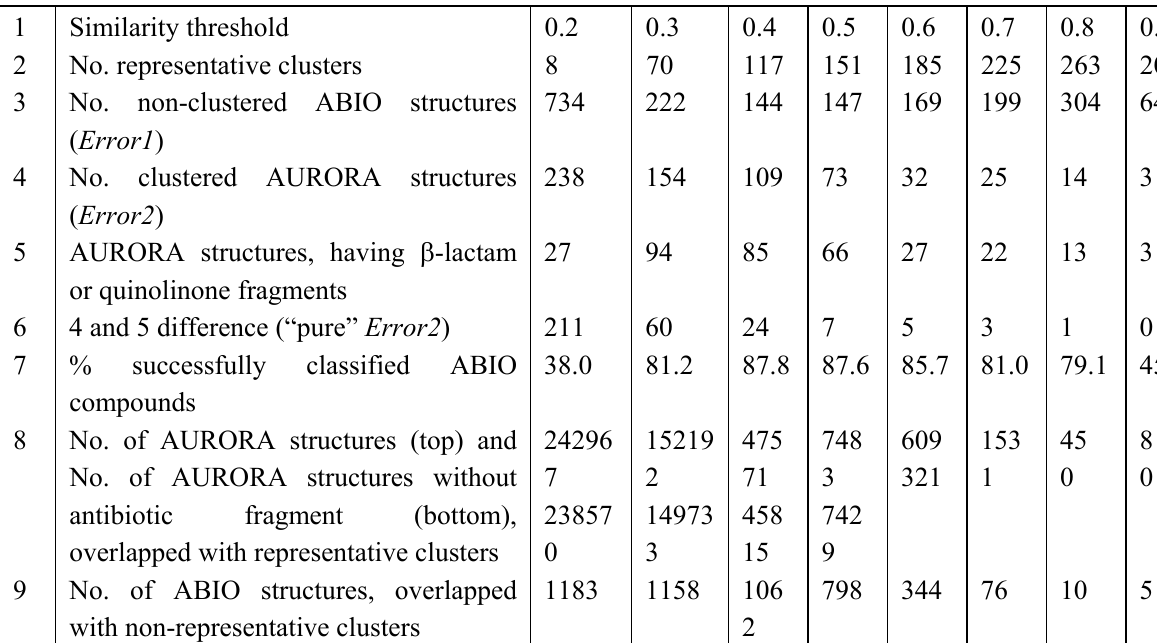
Table 3. Classification errors at different similarity thresholds. The smaller are the values in Rows 3 and 6, the better classification is. The term “Representative clusters” stands for the number of clusters containing over 50% compounds from ABIO